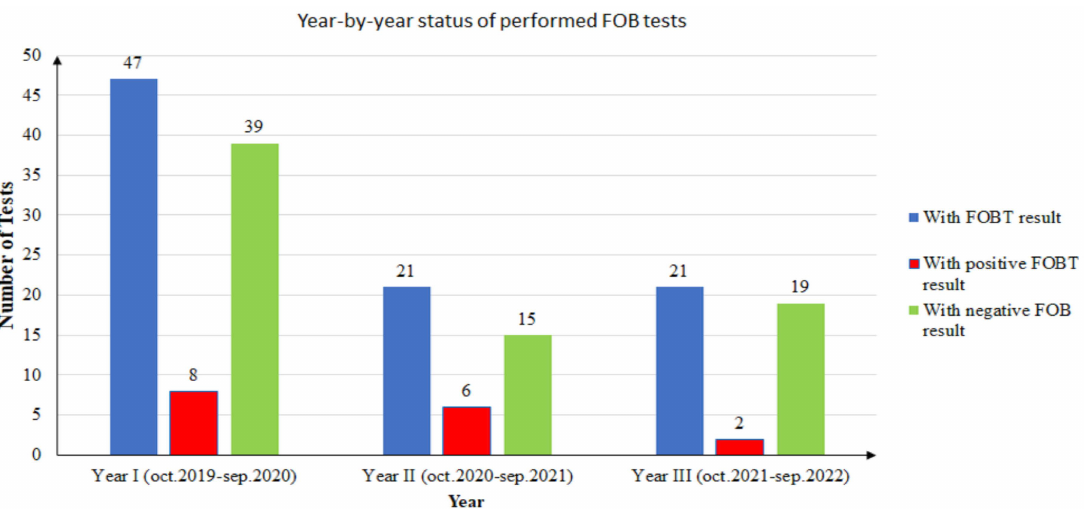
Figure 3. Year-by-year status of performed FOB